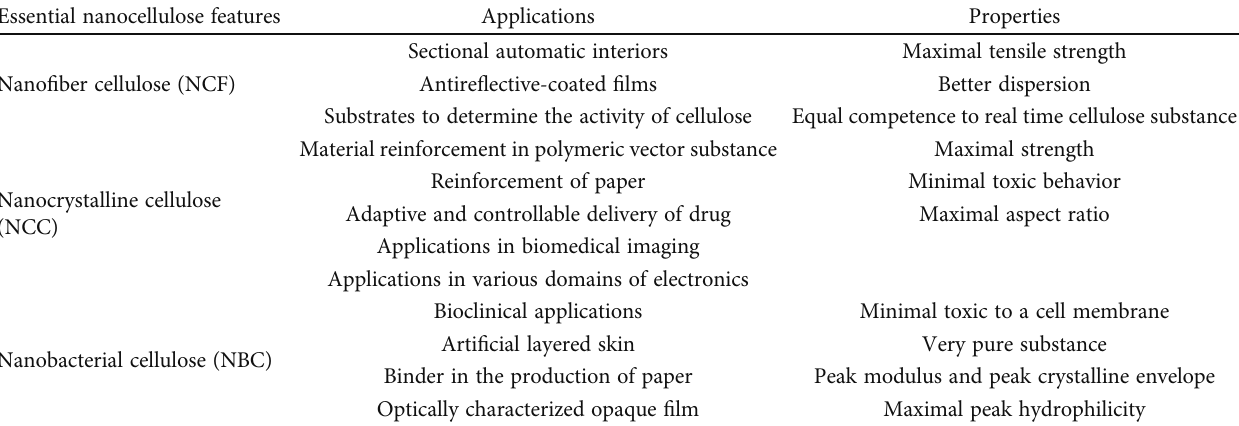
Table 1: Summary of nanocellulose-essential and capable-trendy